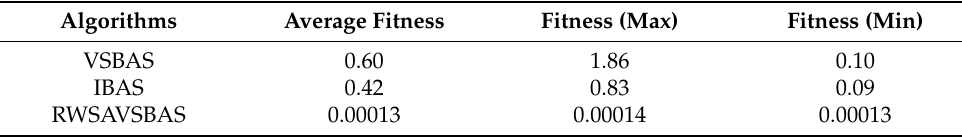
Table 1. Comparison of the average adaptation degree of each algorithm.